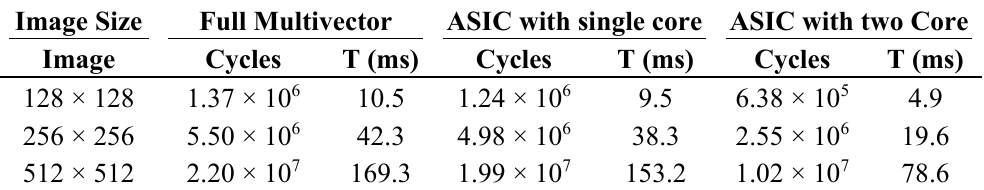
Table 9. One geometric product for rotor convolution.